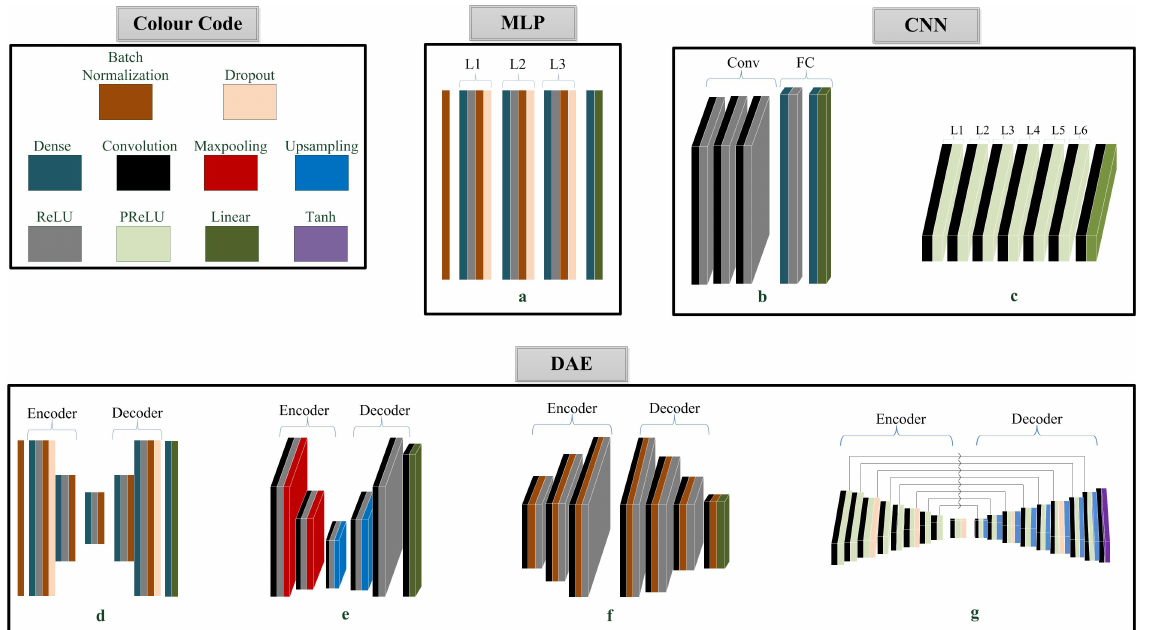
Figure 2. The seven DNN-based speech enhancement architectures: ( a ) MLP, ( b ) the basic CNN, ( c ) the FCNN, ( d ) the DDAE, ( e ) the basic CDAE, ( f ) a special type of CDAE, and ( g ) the deep